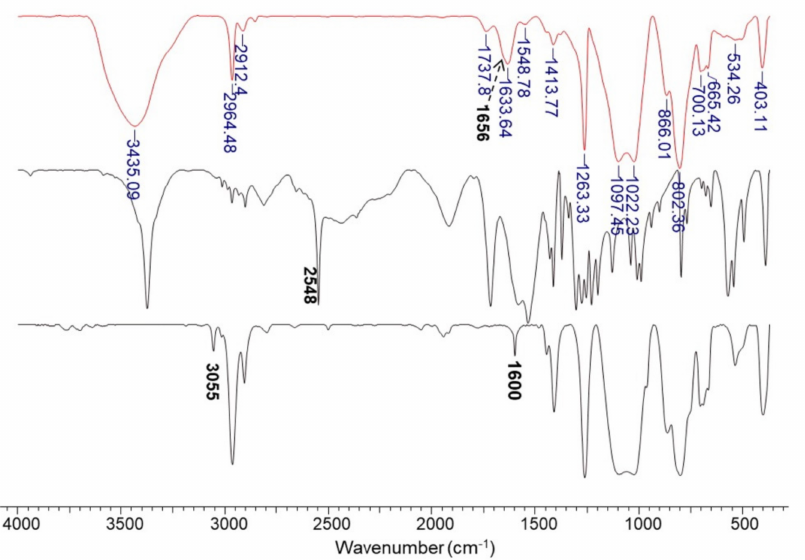
Figure 1. The FT-IR spectra of PNAC-10-100 ( red line ), NAC ( black line ), and ViMSi copolymer ( blue line